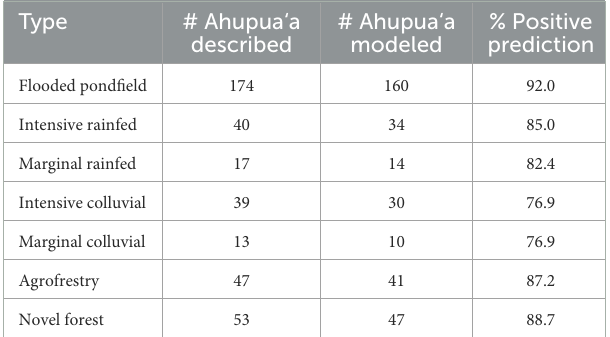
and Marginal Rainfed agriculture, were higher for these younger, TABLE 3 Comparison of agroecological distribution described in Handy (1940) and corresponding representation of those forms in the modeled